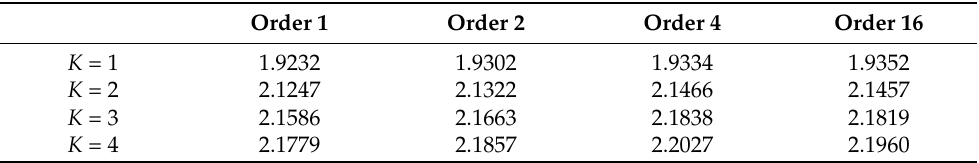
Table 3. BIC values for polynomial regression mixtures for different values of K and orders. The maximum BIC value is obtained for K = 4 and order 4.